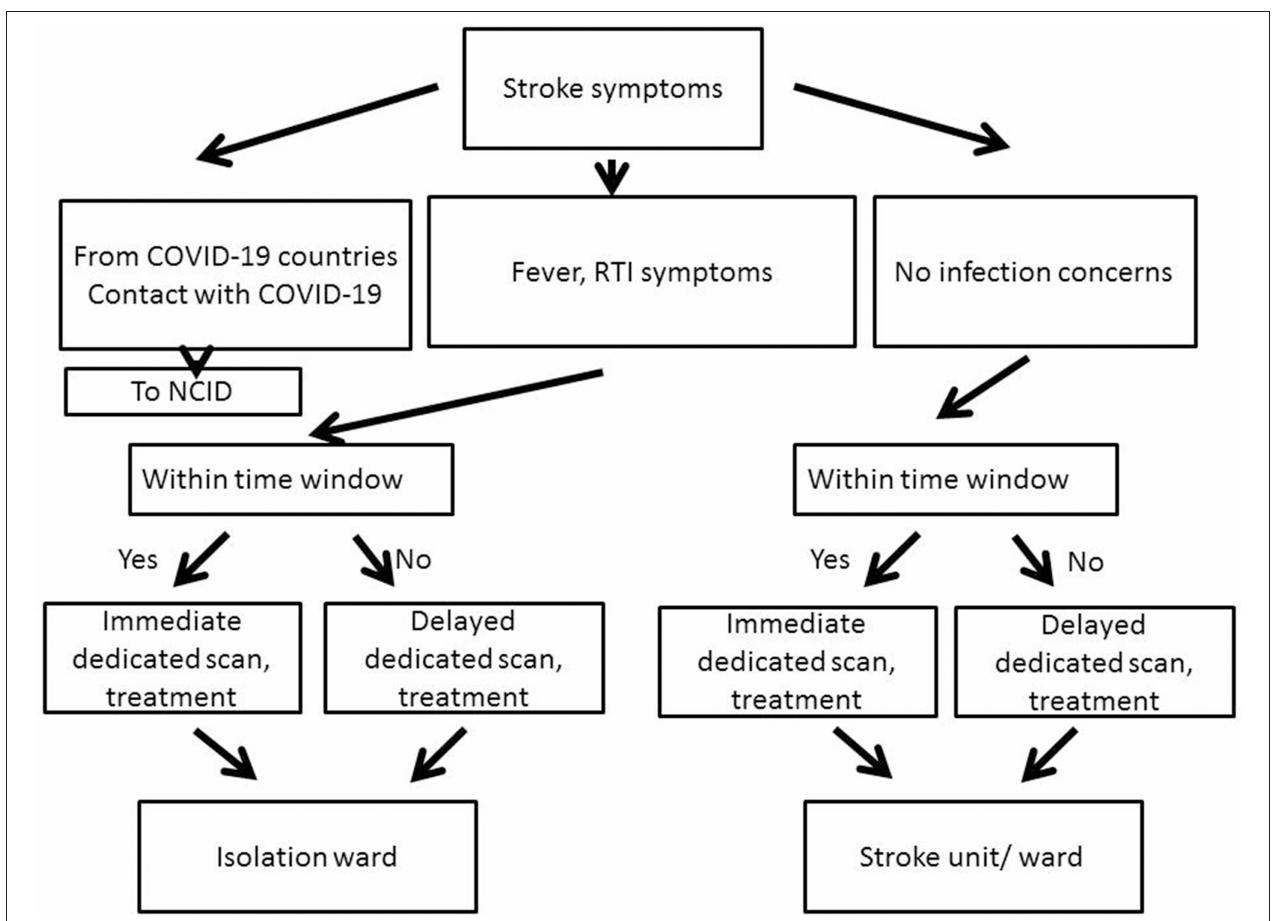
FIGURE 1 | Workflow in the Emergency Department. All patients arriving within the time window for hyperacute therapy are sent for immediate imaging; those who arrive beyond the time window are scanned later at the next available slot, usually later that same day. This applies to both with and without infection concerns (NCID, National Center for Infectious Diseases; RTI, Respiratory Tract